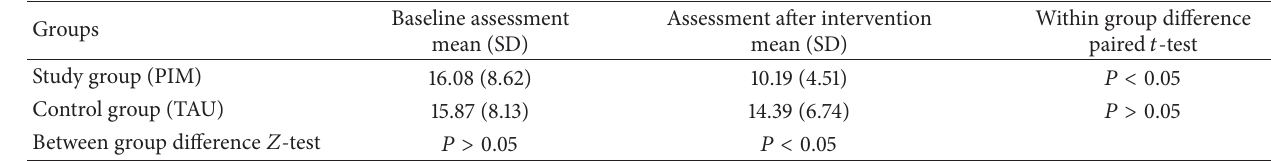
Table 2: Carroll Rating Scale for Depression before and after psychological